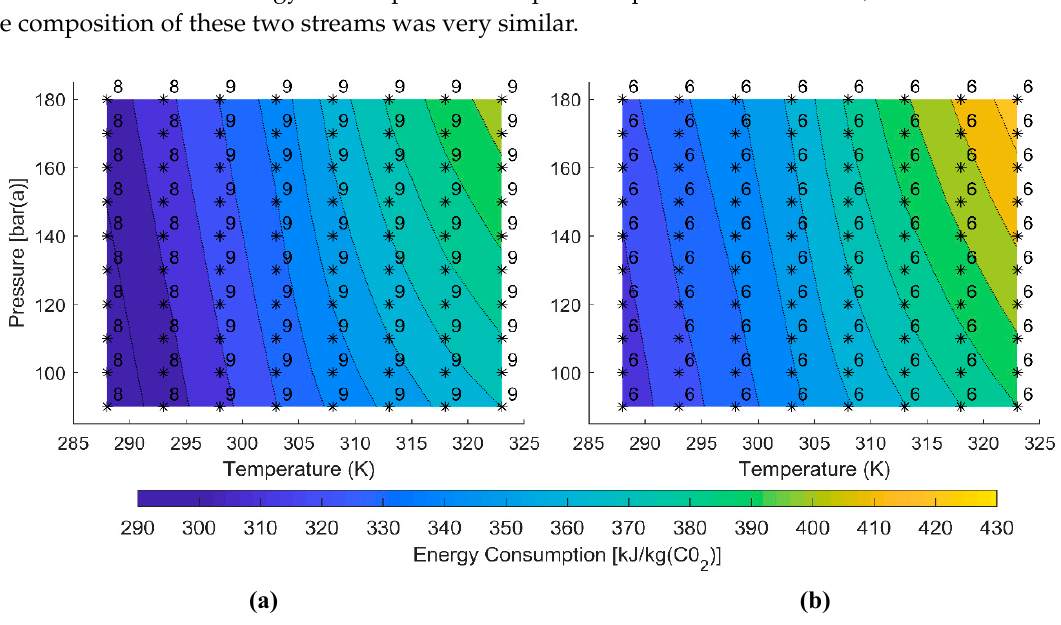
Figure 7. Post-combustion capture cases, optimized compression energy consumption and number of stages, (a) constrained cases and (b) unconstrained cases.